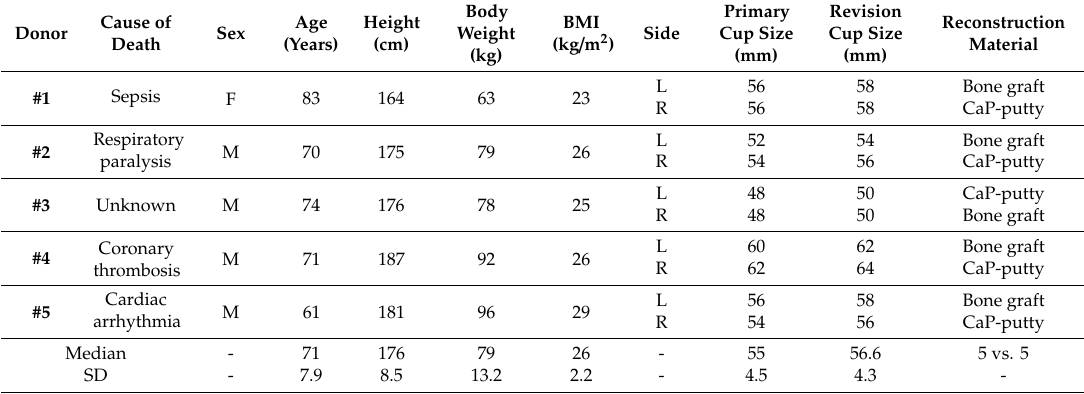
Table 1. List of specimens, including the donors’ details, and the size of the implanted cups. The last column reports the di ff erence between the two reconstruction materials for the acetabular